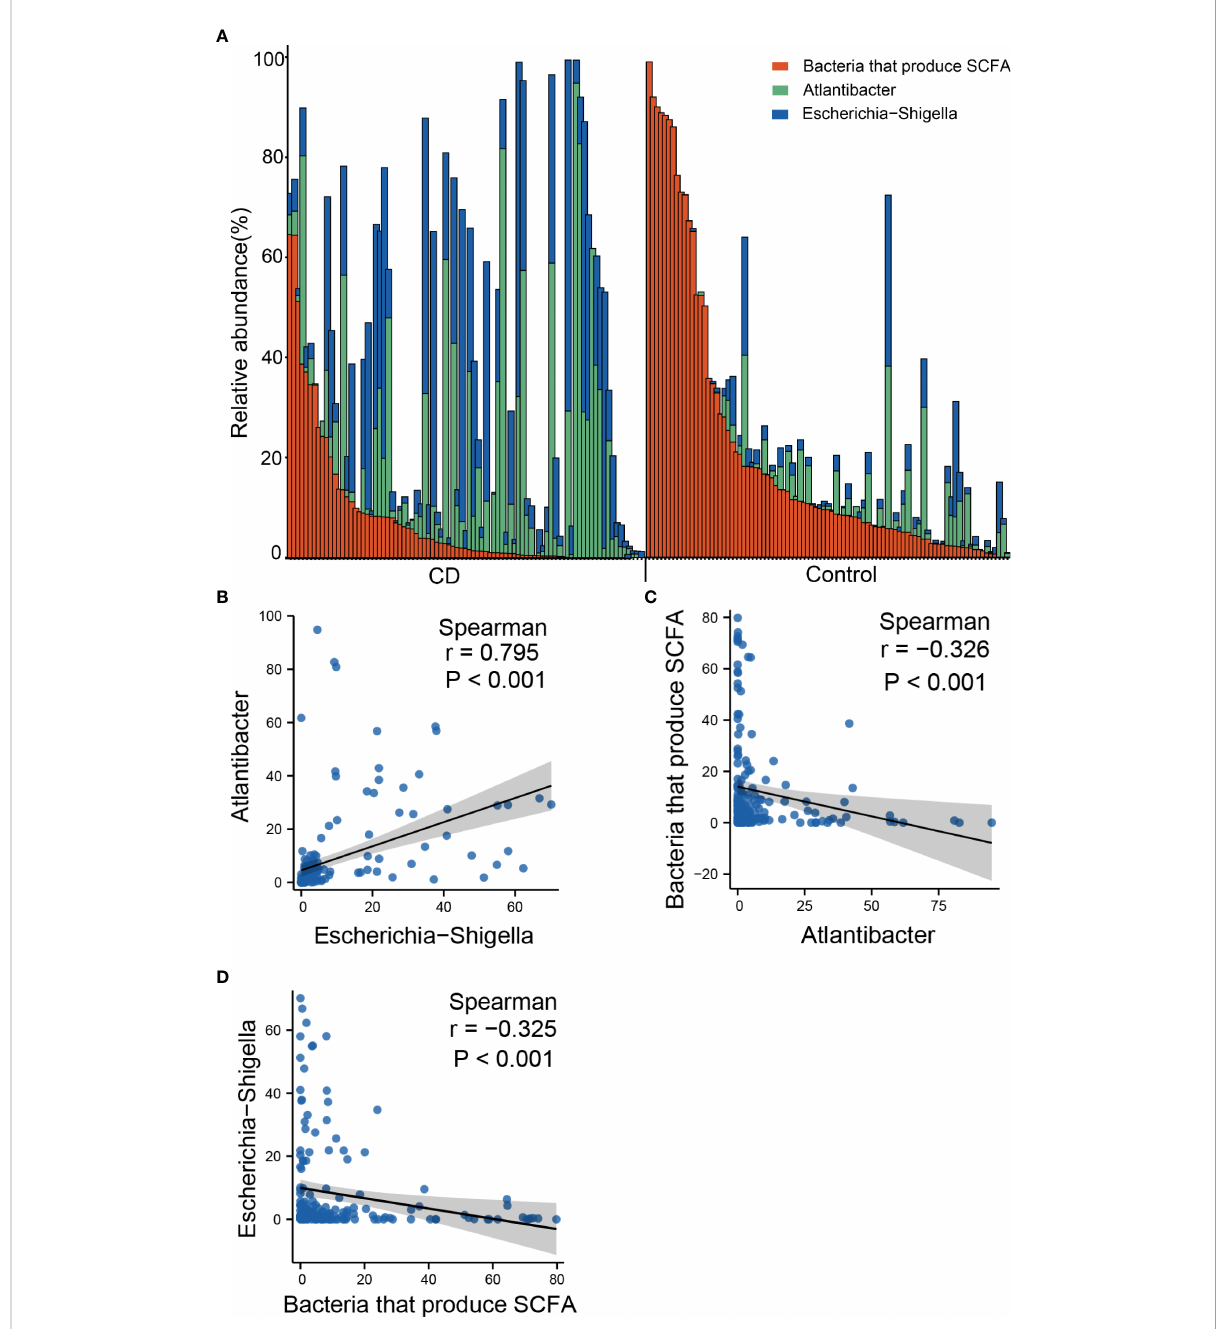
FIGURE 7 Co-occurrence of altered abundances of Escherichia-Shigella, Atlantibacter and SCFA-producing bacteria. (A) Bar plot of relative abundances of Escherichia-Shigella, Atlantibacter and bacteria that produce SCFA. (B) Scatter plot showing the correlation of the abundances between Escherichia-Shigella and Atlantibacter . (C) Scatter plot showing the correlation of the abundances between Escherichia-Shigella and SCFA- producing genera. (D) Scatter plot showing the correlation of the abundances between Atlantibacter and SCFA-producing genera. Spearman ’ s correlation coef fi cients and P values are